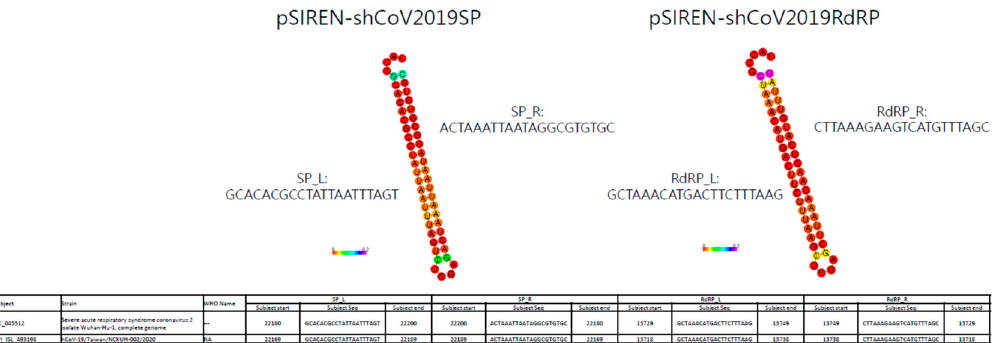
Figure 5. Gene sequence alignment of RdRP and SP shRNA vs. SARS-CoV-2 viruses. We compared the sequence alignment of viral sequences, including the Wuhan-Hu-1 strain and the hCoV-19/Tai- wan/NCKUH-002/2020 strain, with the RdRP and SP shRNA targeting sequences.